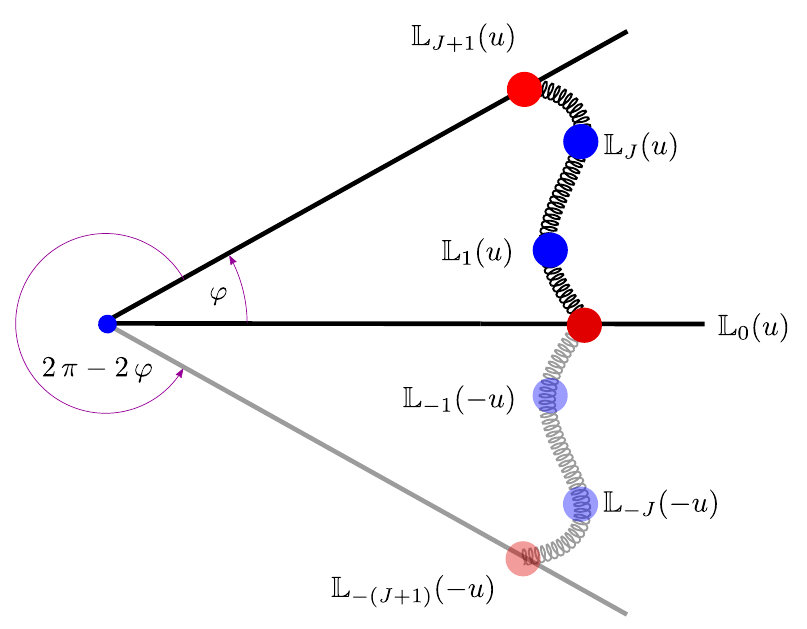
Figure 4. Schematic representation of our method of images